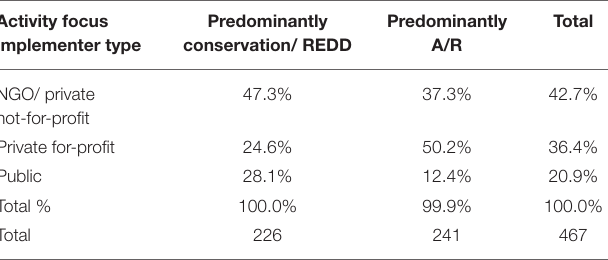
TABLE 1 | REDD + project types in the 2018 ID-RECCO database, by implementer typology and activity focus. Activity focus implementer